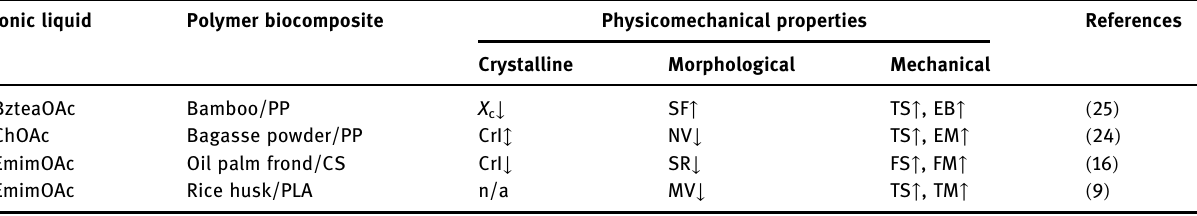
Table 5: Physicomechanical properties of polymer biocomposites pretreated with acetate - based ionic liquids Ionic